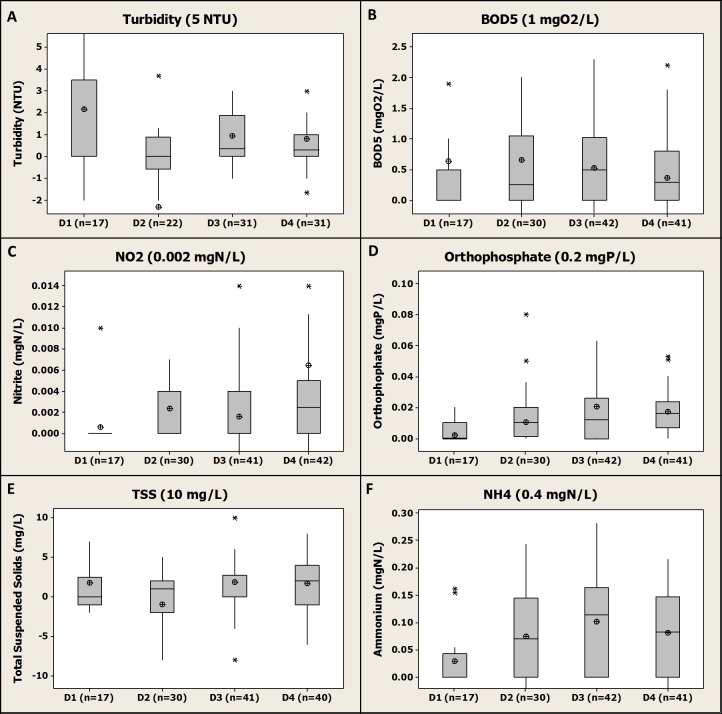
Box-plot representation of the differential concentrations (Di) between inlet and outlet of each of the four fish farms and for each regulated parameter (2005–2015).Numbers 1, 2, 3 and 4 represent the consecutive fish farms in the order of the river flow direction. In brackets, the discharge licence limit value for each regulated parameter as mentioned in the discharge licence. Median, average, Q1 and Q3 are presented. For NH4-N, the limit value associated is for total ammonia (TAN).